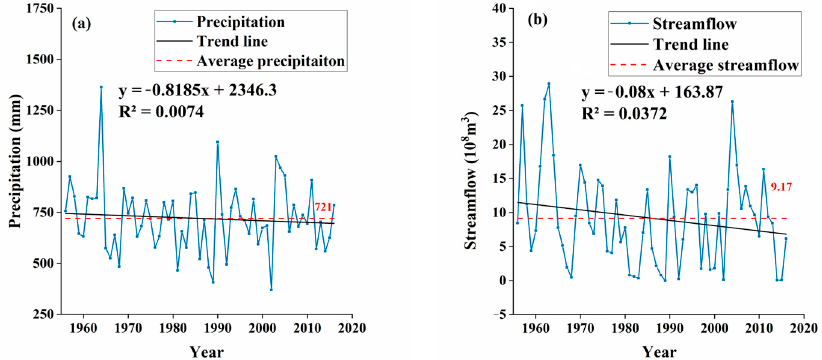
Figure 2. Precipitation ( a ) and streamflow ( b ) trend map of Dawen River Daicun Dam Basin.